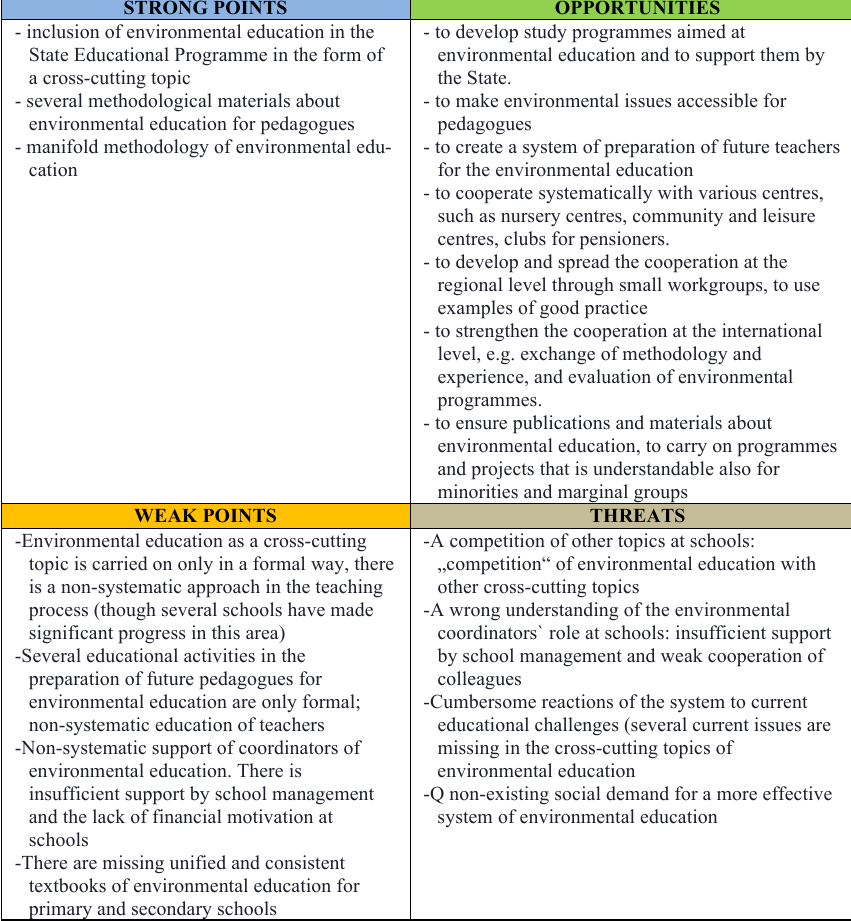
Table 1. SWOT analysis in the area of environmental education in Slovakia (chosen parts